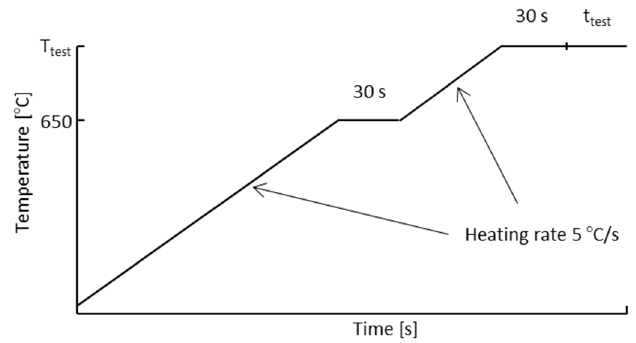
Figure 1. Generic temperature profile for heating of the test samples.